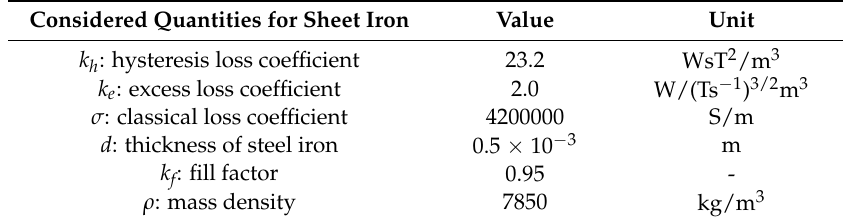
Table 2. Iron losses calculation coefficient values of the Bertotti method for M400-50A lamination.